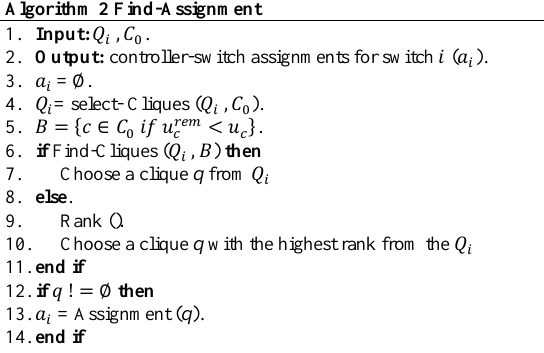
Algorithm 2 Find-Assignment 1. Input: 𝑄 𝑖 ,𝐶 0